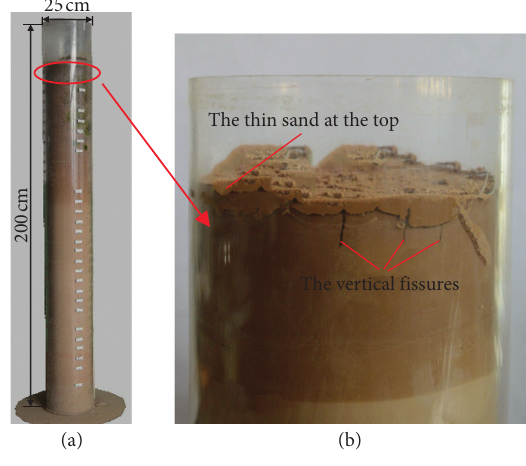
Figure 5: (a) The model experiment and (b) fissure phenomena after water penetration.